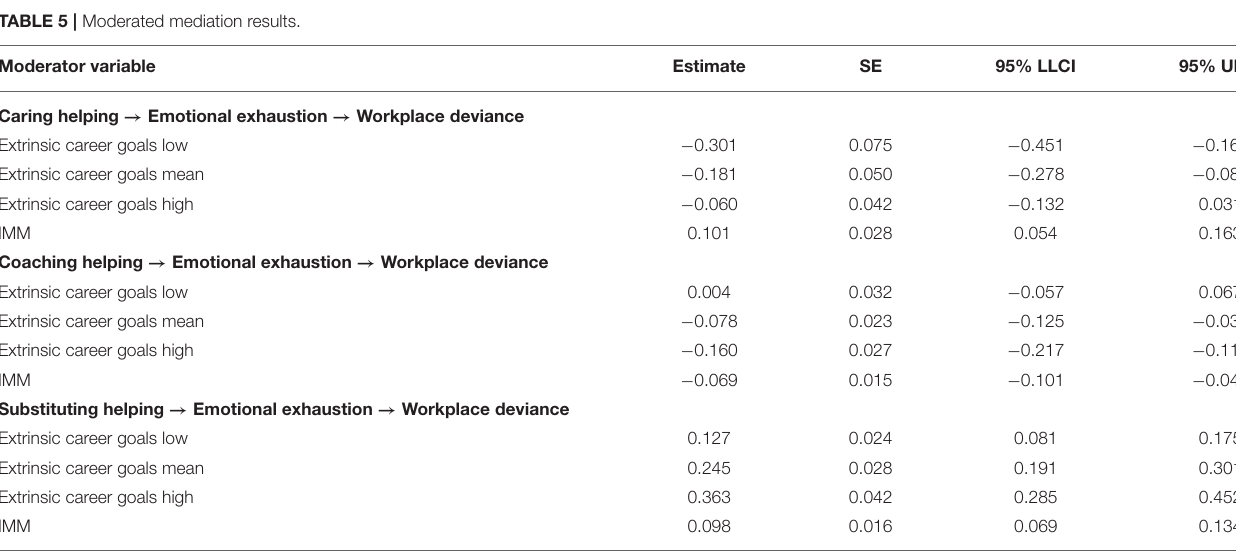
TABLE 5 | Moderated mediation